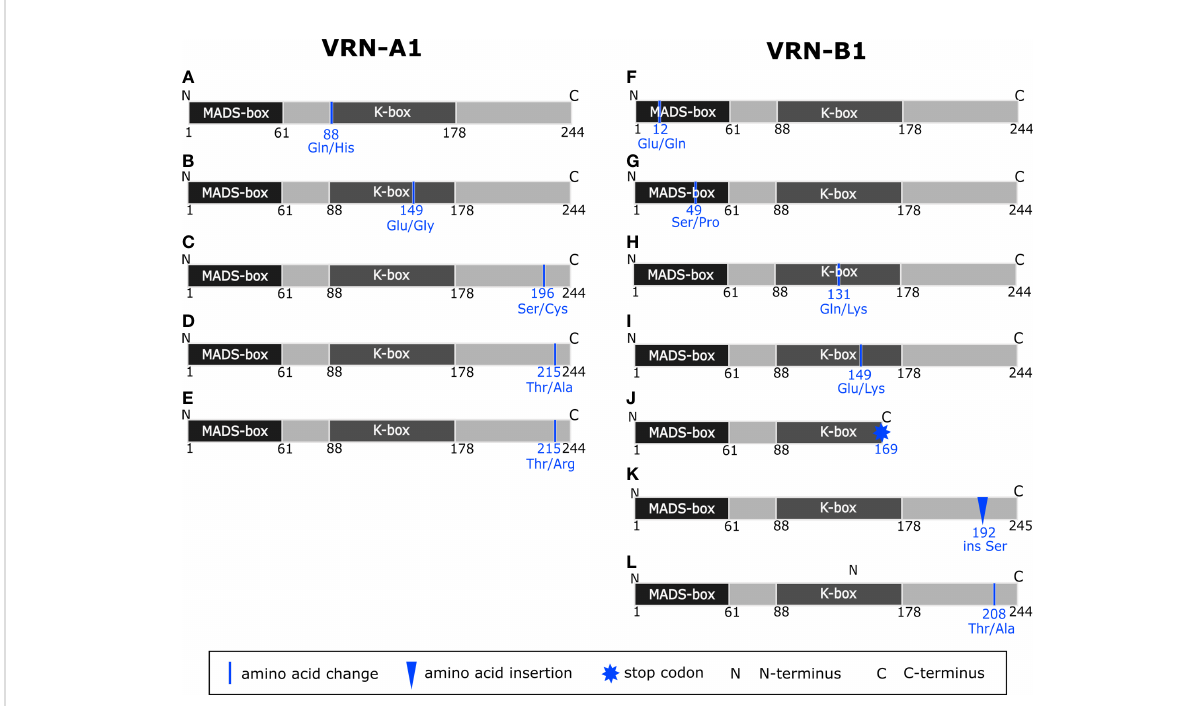
FIGURE 4 Schematic representation of predicted variants of VRN-A1 (A – E) and VRN-B1 (F – L) proteins based on the change in the nucleotide sequence of VRN-A1 and VRN-B1 genes, respectively. Domains were identi fi ed using the InterPro database (Mulder et al.,